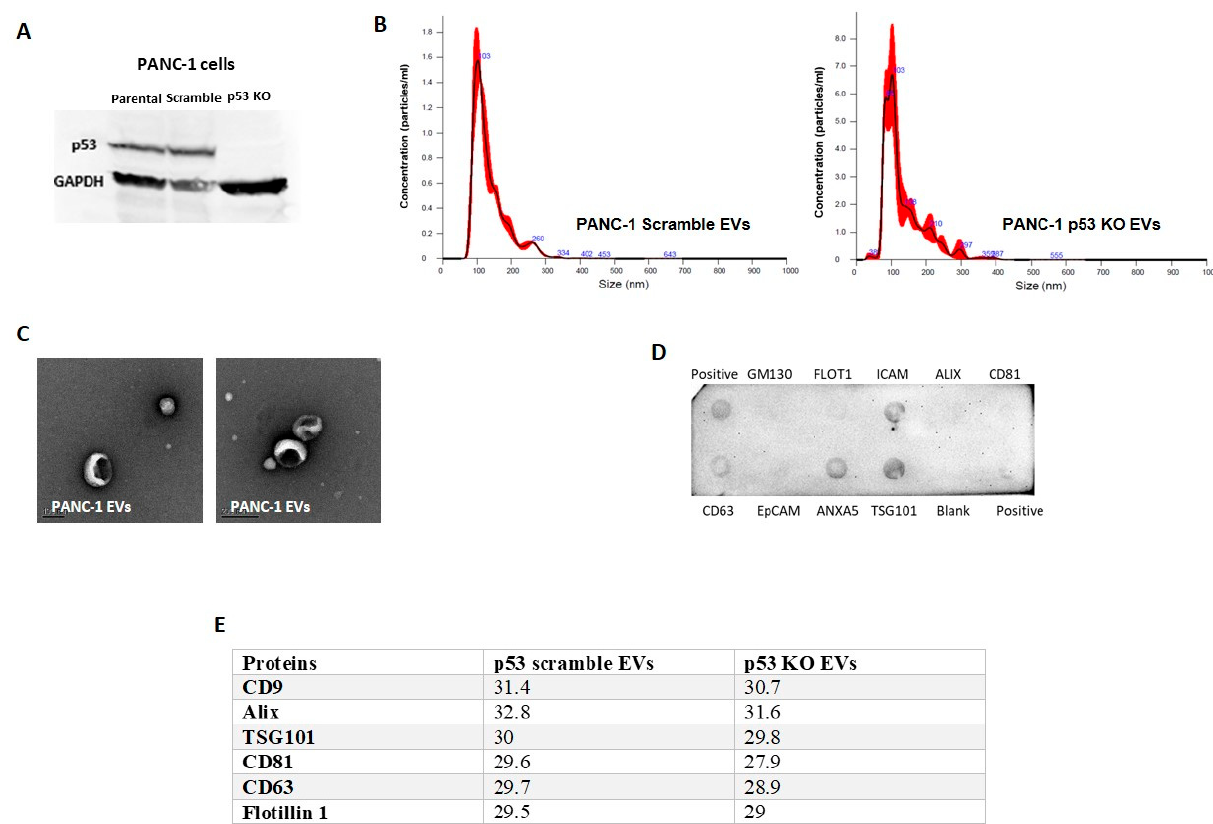
Figure 1. Characterization of EVs from mutp53-harboring cancer cells. The R273H GOF mutant p53 in PANC-1 cells was knocked out (using CRISPR Cas-9) as depicted in ( A ), where lysates from parental PANC-1 cells, Cas-9 scrambled, and Cas-9 KO were incubated with a p53 antibody (GAPDH was used as a loading control). EVs from PANC-1 cells were isolated using serial ultracentrifugations (UC) and were characterized using several methodologies including ( B ) nanoparticle tracking analysis (NTA), ( C ) electron microscopy, ( D ) exo-check membrane with several exosomal markers, and ( E ) proteomic comparison of several exosomal markers between scramble EVs and KO EVs. Log2(0) was replaced with 21 (the threshold intensity in the